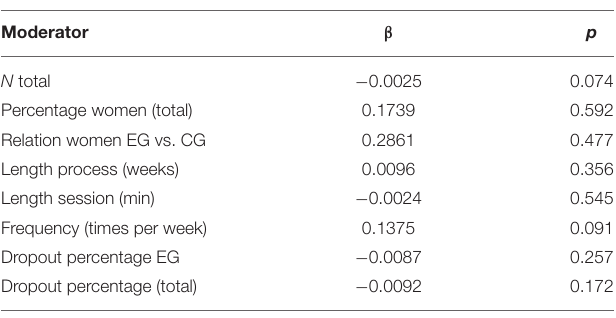
TABLE 4 | Metric moderators.